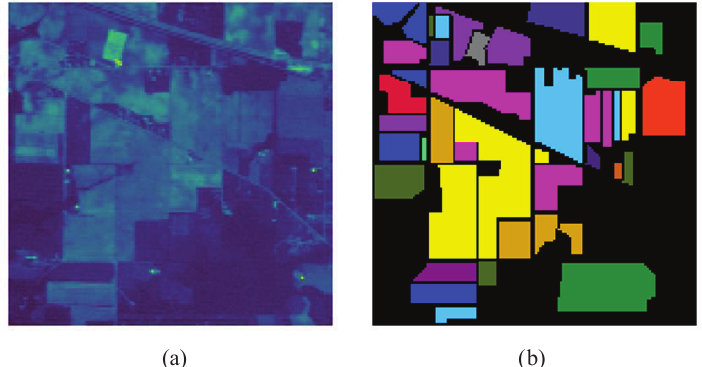
Figure 4. The Indian Pines data set. ( a ) A false color map. ( b ) The ground truth map.